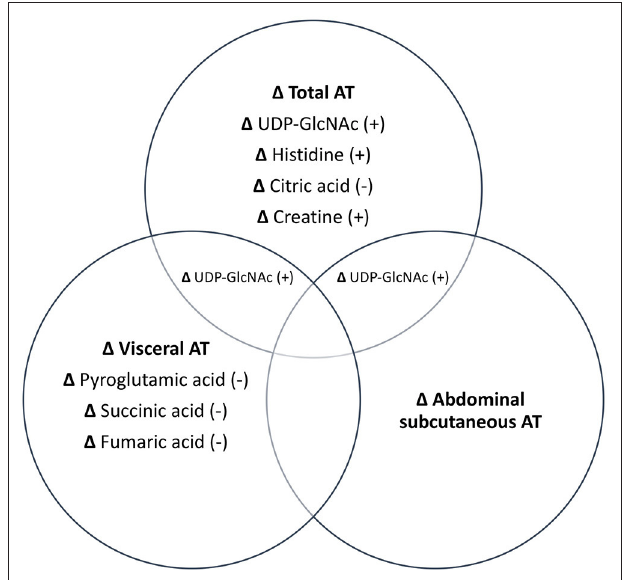
FIGURE 1 | Independent and combined associations between changes in metabolites and changes in AT depots. All metabolites listed are significant at p < 0.05. + , positive association; –, negative association.